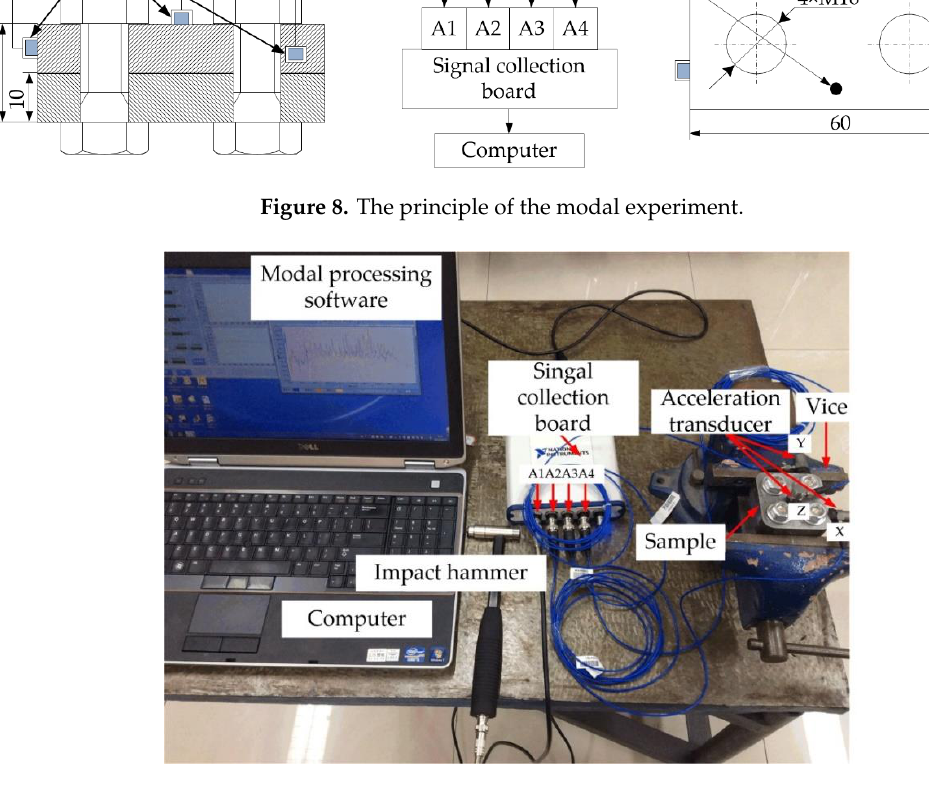
Figure 9. The field of the modal experiment.